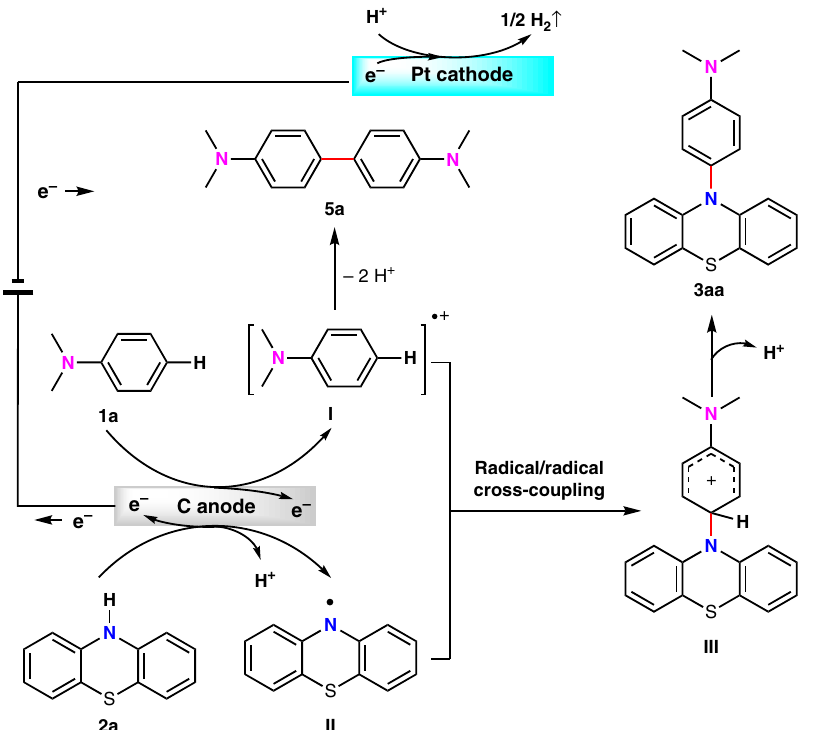
Fig. 8 Proposed mechanism for the reaction between 1a and 2a . Tentative reaction mechanism involves anodic oxidation of aniline to generate aniline cation radical and diphenylamine to generate nitrogen radical, cross-coupling of aniline cation radical with nitrogen radical and deprotonation to furnish the fi nal